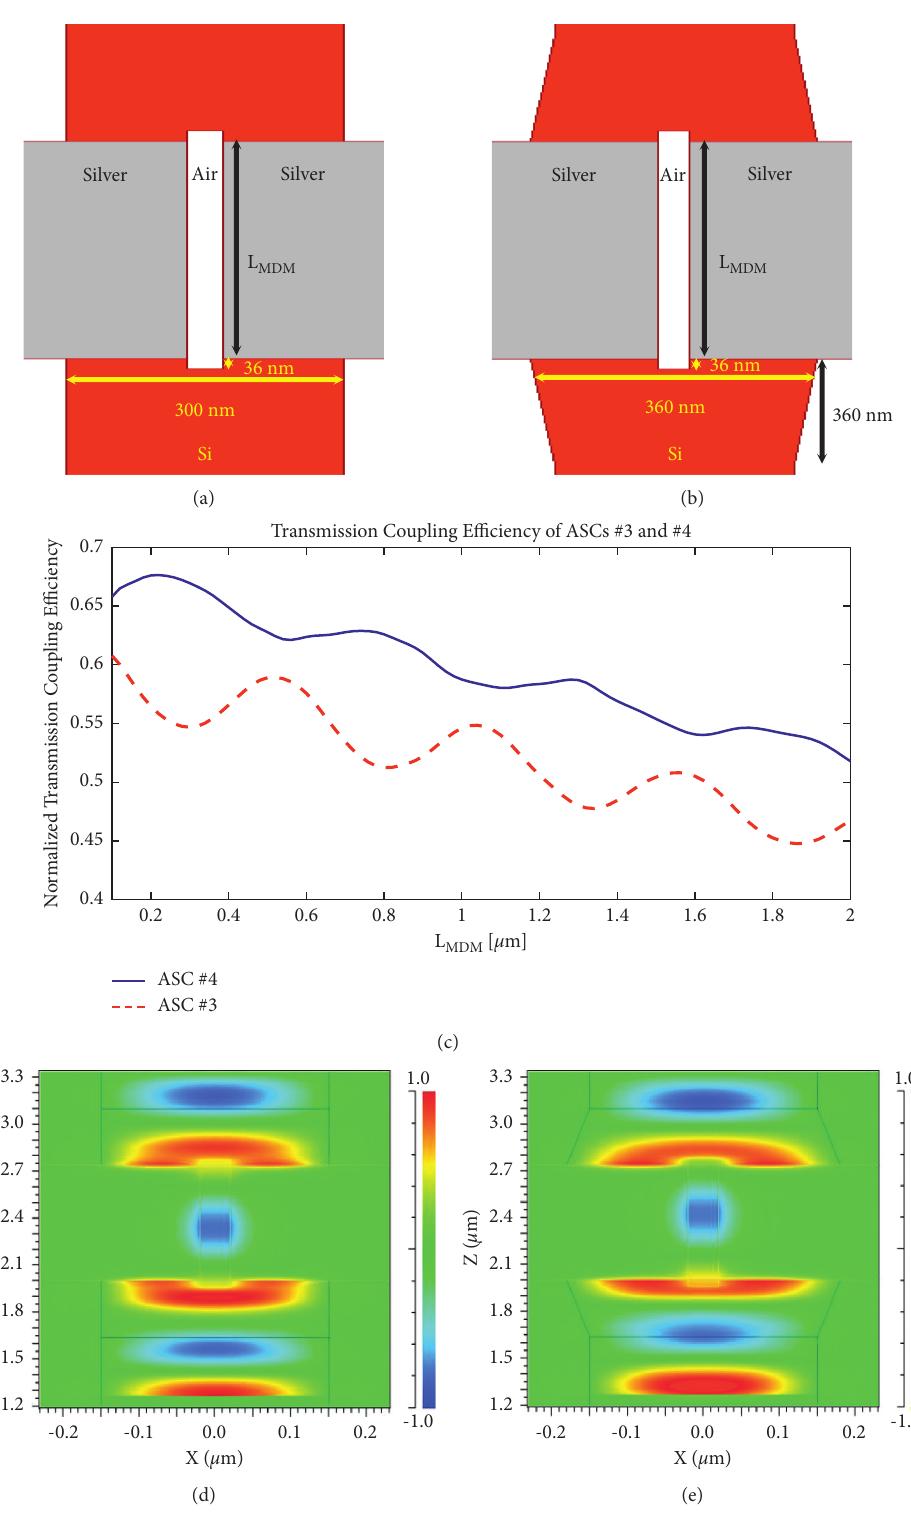
Figure 2: The schematics of the proposed ASCs #3 and #4 that show how light couples into and out of the MDM plasmonic waveguide: (a) ASC #3 without the dielectric width expansion that resulted from connecting two #1 ASCs back to back, (b) ASC #4 with the dielectric width expansion that resulted from connecting two #2 ASCs back to back, (c) transmission coupling efficiency as a function of the length of the MDM plasmonic waveguide, L MDM , for both ASCs #3 and #4, and (d, e) field distributions of the coupled light at 1550nm for ASCs #3 and #4 when L MDM �